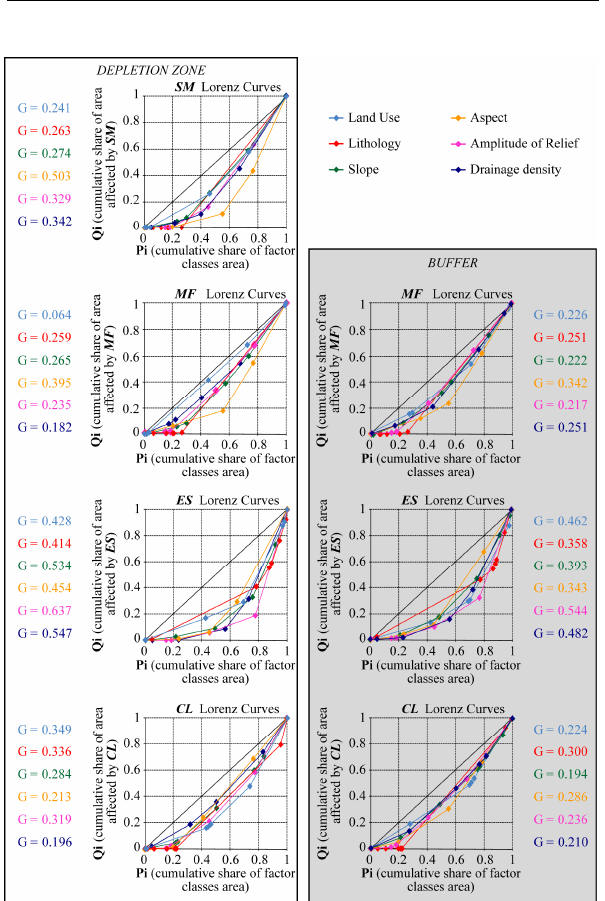
Fig. 7. Lorenz curves for each causal factor and each landslide type. Different curves are computed for depletion zones (or the whole area affected by shallow mass movements) and for the 50m outer buffer